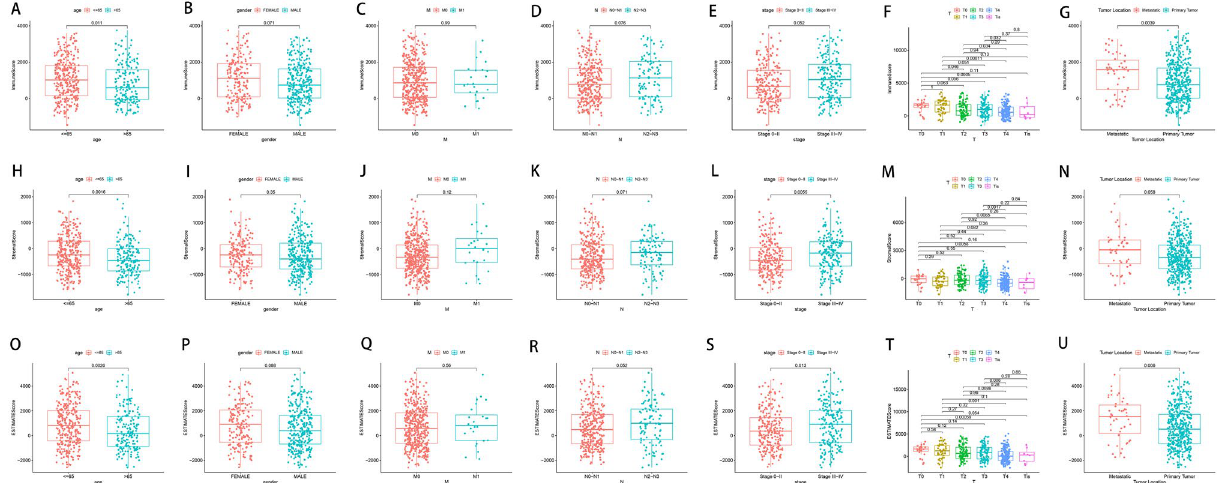
Figure 3. Associations of ImmuneScore, StromalScore, and ESTIMATEScore with clinicopathologic features. Kruskal–Wallis rank sum tests of the associations of ( A – G ) ImmuneScore, ( H – N ) StromalScore, and ( O – U ) ESTIMATEScore with clinicopathologic features. This figure was generated using “ggplot2” R